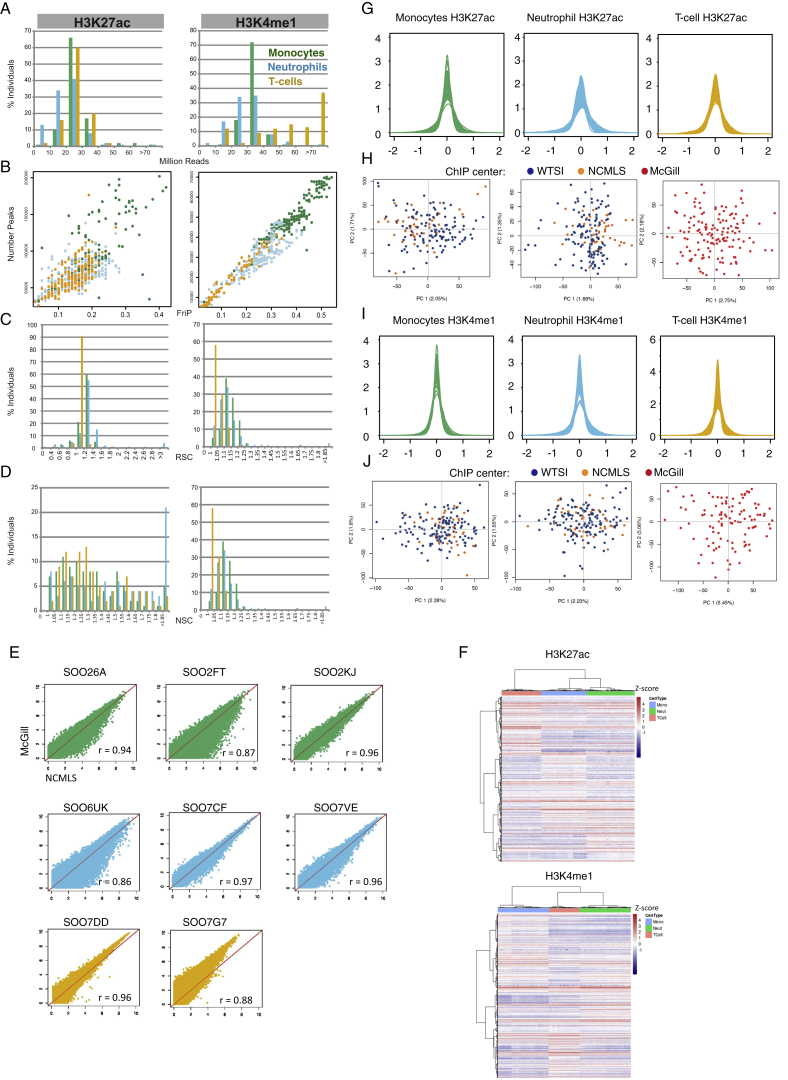
ChiP-Sequencing Data Quality Metrics, Related to Figure 3(A–D) ChIP-seq quality control plots with consistent color convention throughout; Neutrophil (blue), Monocyte (green) and T cell (yellow). Plots are split by factor assayed, H3K4me1 (left) and H3K27ac (right). (A) Histogram displaying bins of quality control passed reads on x axis and percent of individuals falling into each bin on y axis. (B) Scatterplot displaying number of peaks called at FDR threshold per individual and colored by cell type is shown on x axis. On the y axis fraction of reads intersecting a consensus peak set of regions shared across all three cell types. (C) Histogram displaying bins of normalized strand coefficient on x axis, y axis percent of individual which fall into each bin. (D) Histogram displaying bins of relative strand coefficient on x axis, y axis percent of individual which fall into each bin.(E and F) Scatterplot showing the Pearson correlation r between replicates of same donors processed at NCMLS and McGill (F) Hierarchical clustering for each histone modification marker using Pearson correlation as distance metrics and standardized log2 RPM (Reads Per Million) in chromosome 1 only. Similar clustering is likewise seen for all chromosomes.(G–J) PEER corrected matrices of log2 RPM. Density of log2 RPM values for H3K27ac in (G) and for H3Kme1 in (I). Scatterplot colored by the ChIP center of the first two orthogonal components from PCA for H3K27ac in (H) and for H3Kme1 in (J).